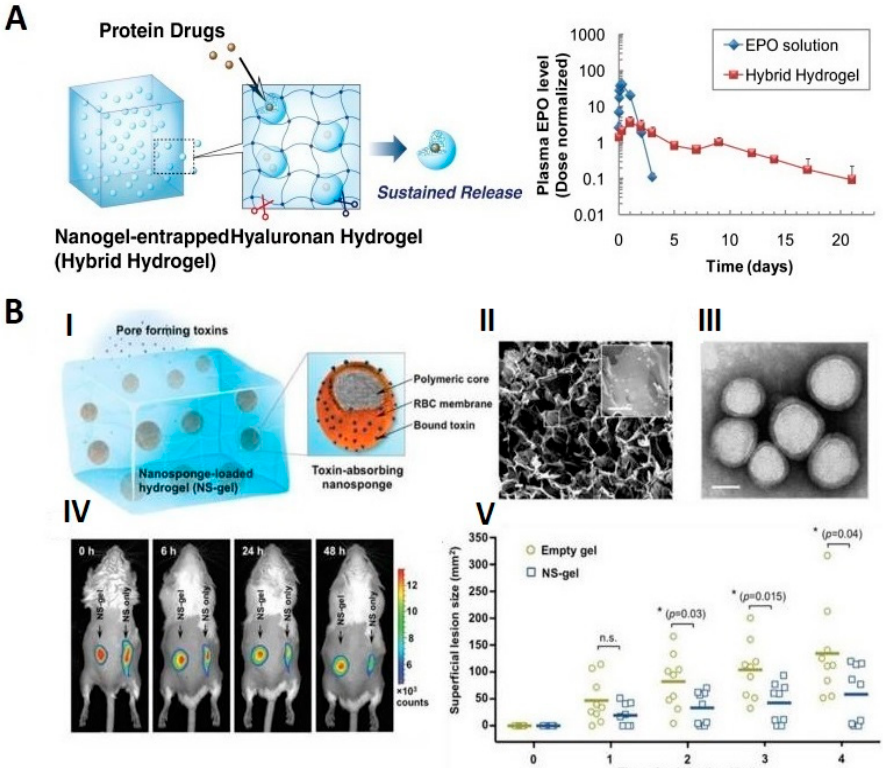
Figure 3. Example constructions of macroscopic hydrogels with entrapped biomolecule hybrid NGs for controlled release of drugs. ( A ) Hybrid macroscopic hydrogel constructed from protein-based / polymeric nanogel and hyaluronic-based (HA) hydrogel, and the sustained release of molecular chaperone-like active therapeutic proteins. Reprinted from Reference [47] with permission from the Elsevier. ( B ) Poly(lactic-co-glycolic acid), (PLGA) polymeric-multilayer nanosponge-loaded polyethylene